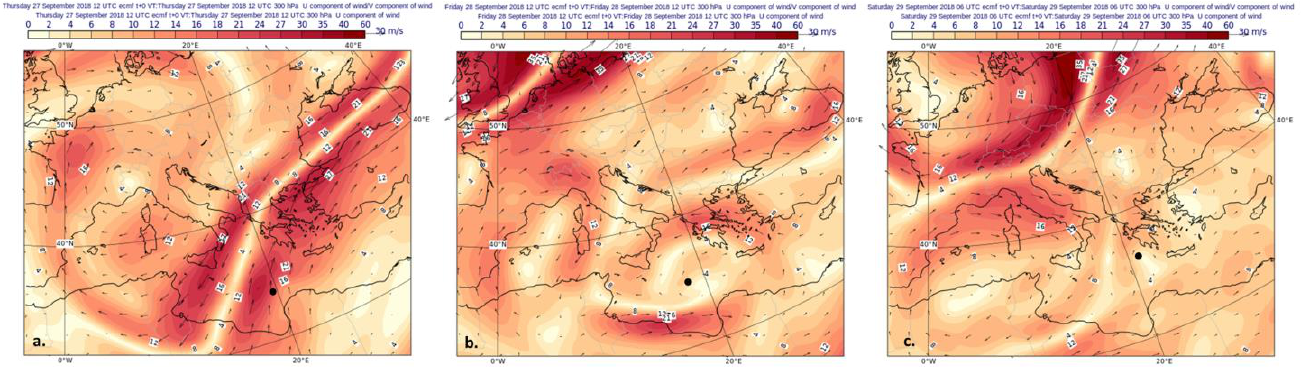
Figure 5. Thermal wind at 600–300 hPa for ( a ) 27/12 UTC, ( b ) 28/12 UTC, and ( c ) 29/06 UTC. Coloured areas denote the magnitude and the vectors the direction of thermal wind. Black dot indicates the location of the system centre.